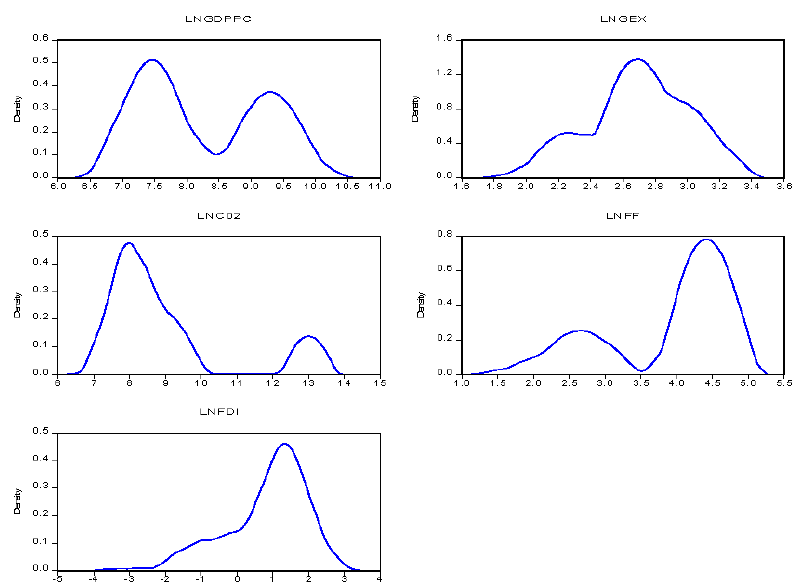
Figure 2. The trend of the indicators-South.